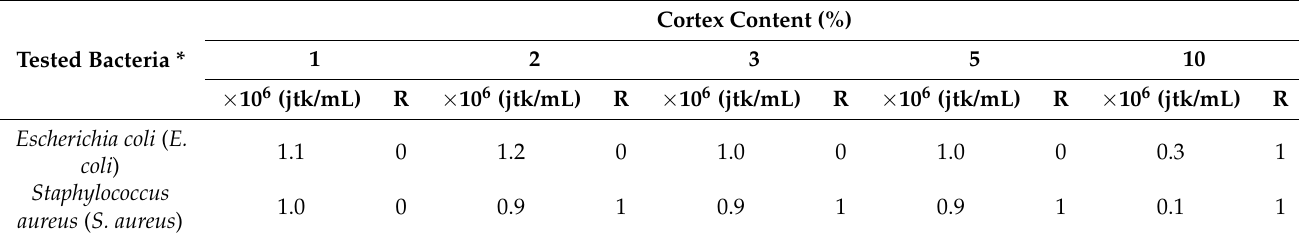
Table 4. The reductions of the numbers of living and viable cells of the tested bacteria. Cortex Content (%) 1 Tested Bacteria *